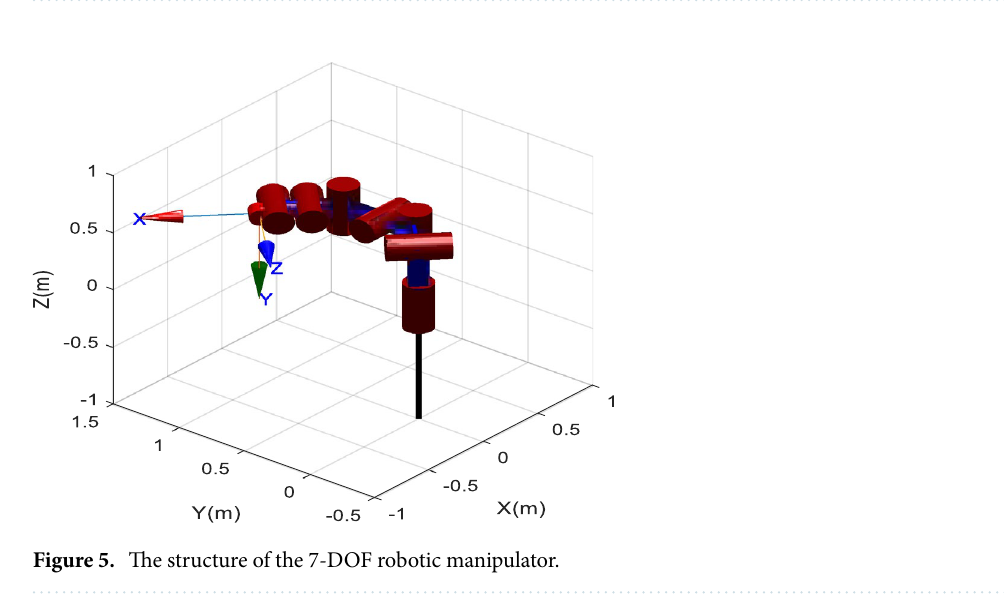
Figure 4. Kinematics analysis of the robotic manipulator.